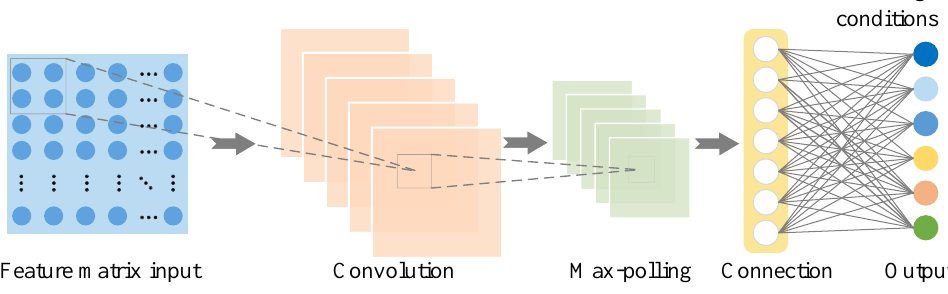
Figure 3. The structure of the CNN model.